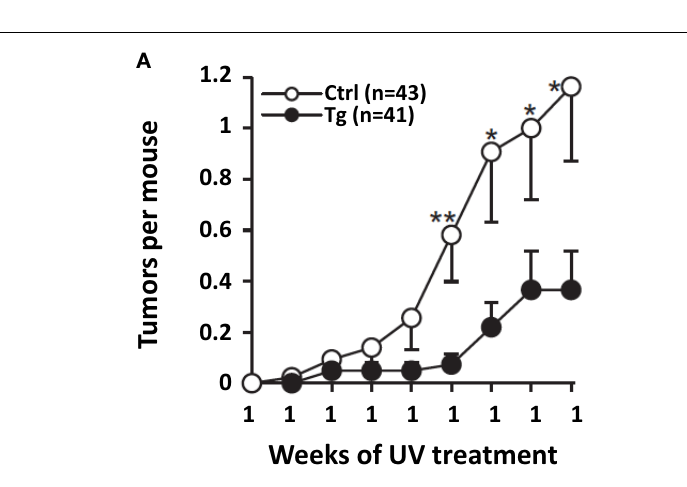
bars = SEM). Statistical significance in mean number of tumors per mouse between the groups was as shown at the indicated time points: * P ≤ 0.05, ** P < 0.01. In (B) , transgenic mice with diminished ATR function (Tg) had fourfold fewer clinically defined invasive SCCs than transgene-negative littermate controls (Ctrl) did, although this result had only borderline statistical significance ( P = 0.071). Mean number of invasive SCCs per mouse after 23week of UV treatment is shown (Error bars = SEM).Taken from Kawasumi et al.